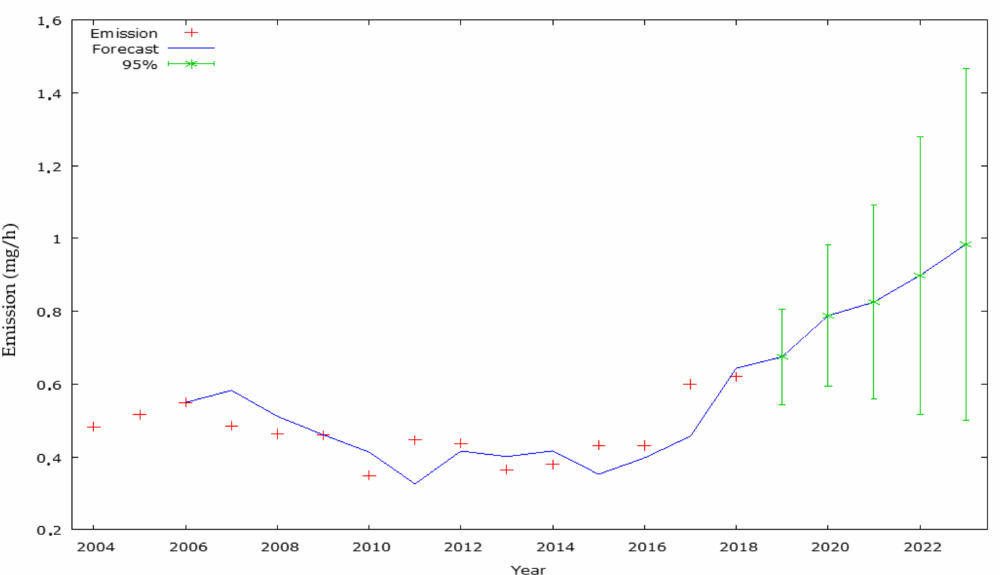
Figure 4. Graph of the dependence of the average CO emission in mg/h in individual years on the values forecasted using the ARIMA model (2,2,0), (averaging time 1-h, average value), zone code PL1401. Source: Own elaboration, based on data from Chief Inspectorate of Environmental Protection